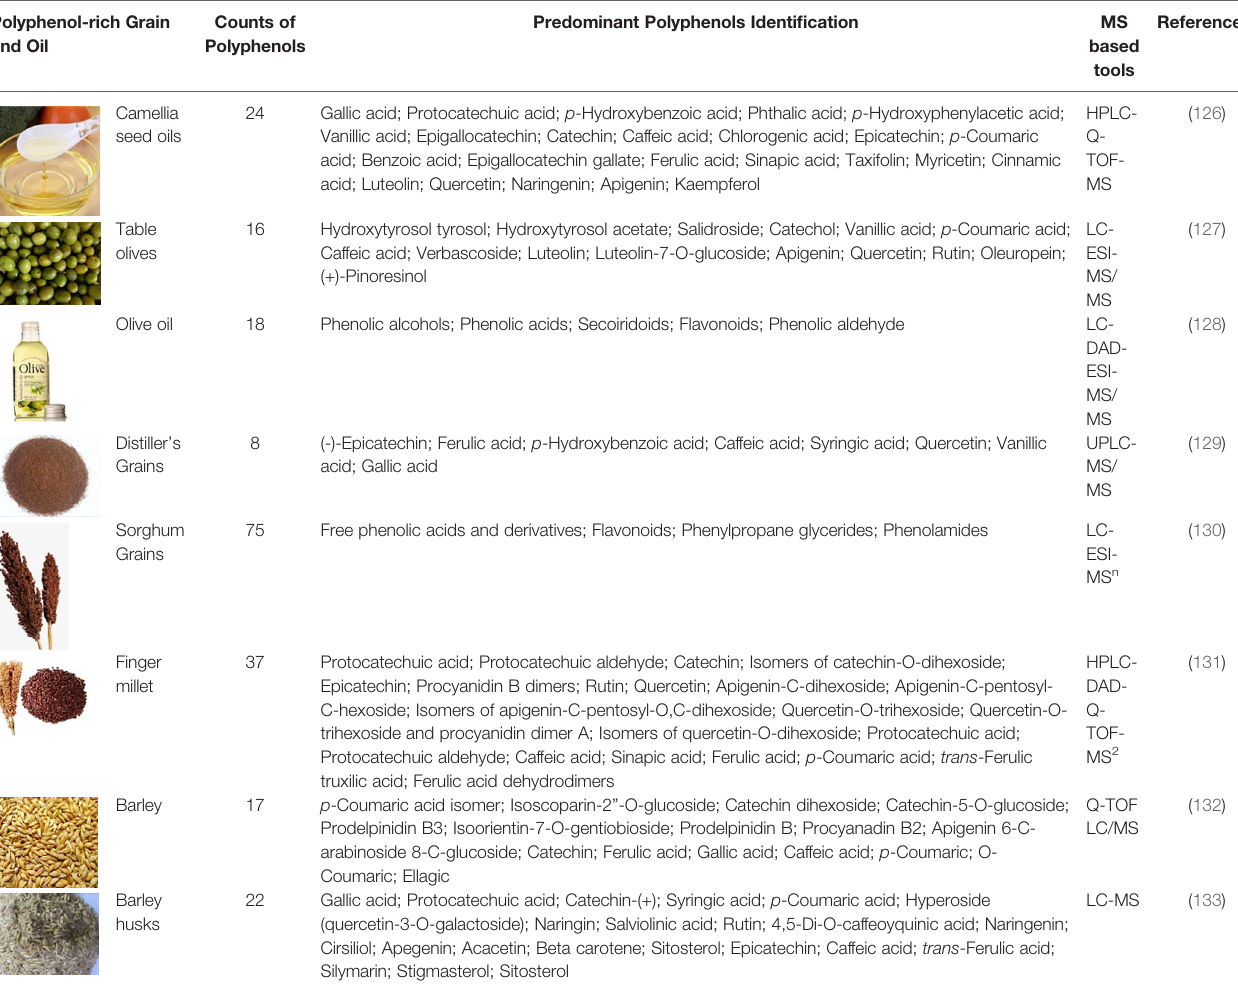
TABLE 1-3 | MS-based foodomics applied to the determination of polyphenolic active compounds in grain and oil. Polyphenol-rich Grain and Oil